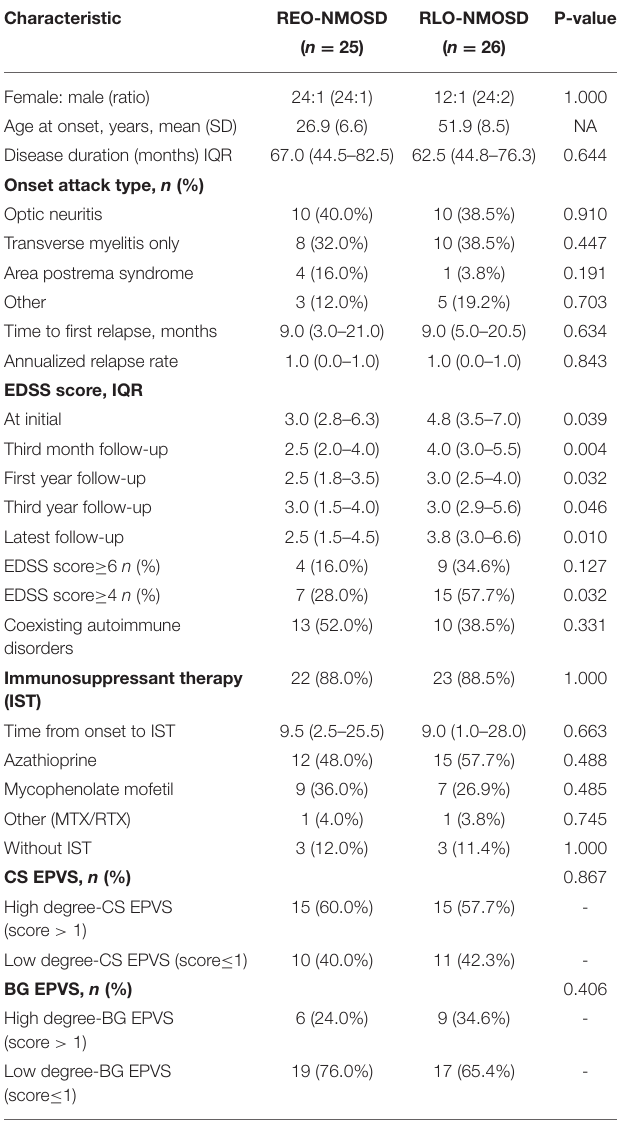
TABLE 2 | The comparison of demographic and clinical features between patients with REO-NMOSD and RLO-NMOSD with AQP4-IgG. Characteristic